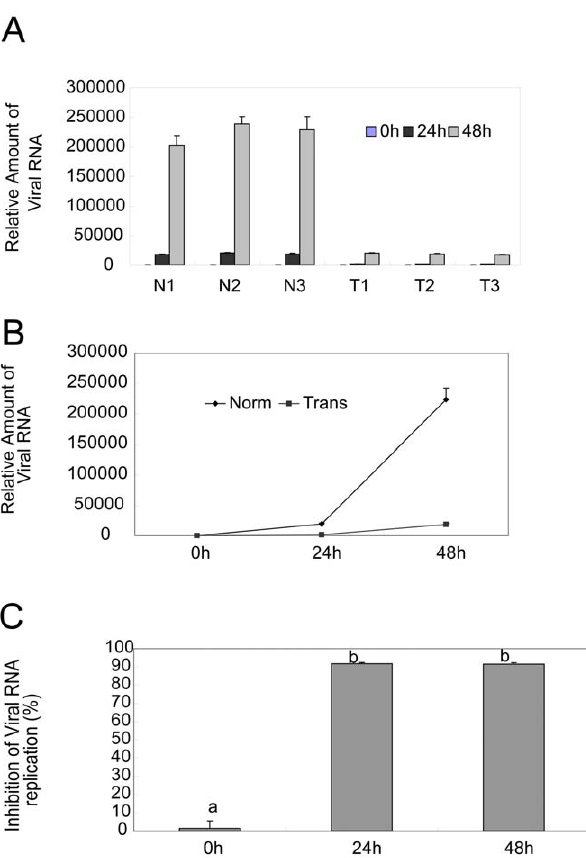
Figure 6. shRNAs protection of primary transgenic bovine tongue epithelium cells from FMDV infection. The primary bovine tongue cells were isolated from three normal or three transgenic fetuses, respectively, cultured in 96-well plates and inoculated with 100 TCID 50 of the FMDV strain each well. Virus samples were collected at indicated time points, and virus titer was then determined. The viral titers in three normal (N1, N2, N3) or three transgenic (T1, T2, T3) cells from three independent experiments were presented as an average number of TCID 50 6 one standard deviation at different time (A), the average viral titers was compared between normal (Norm) and transgenic groups (Trans) (B), and viral inhibition by shRNA in transgenic cells was calculated as 1 minus percentage of average number of TCID 50 of transgenic cells to that of normal controls (C). Duncan’s multiple range test by SAS 8.0 system, means with the same letter are not significantly different (P . 0.01).